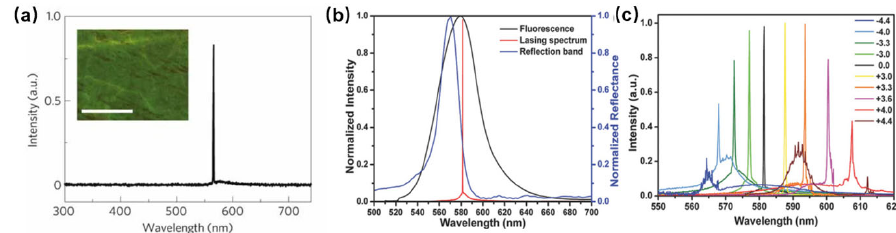
Figure 4. ( a ) Laser emission from the dye ‐ doped BP ‐ templated region; Reprinted with permission from Ref. [10]. Copyright 2012 Springer Nature BV. ( b ) Reflection, fluorescence, and laser emission spectra of the templated BP laser; ( c ) Emission spectra of the templated BP laser at different electric fields. Reprinted with permission from Ref. [68]. Copyright 2018 John Wiley and Sons.